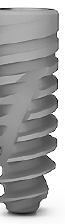
Figure 2. ICX Active Master implant.